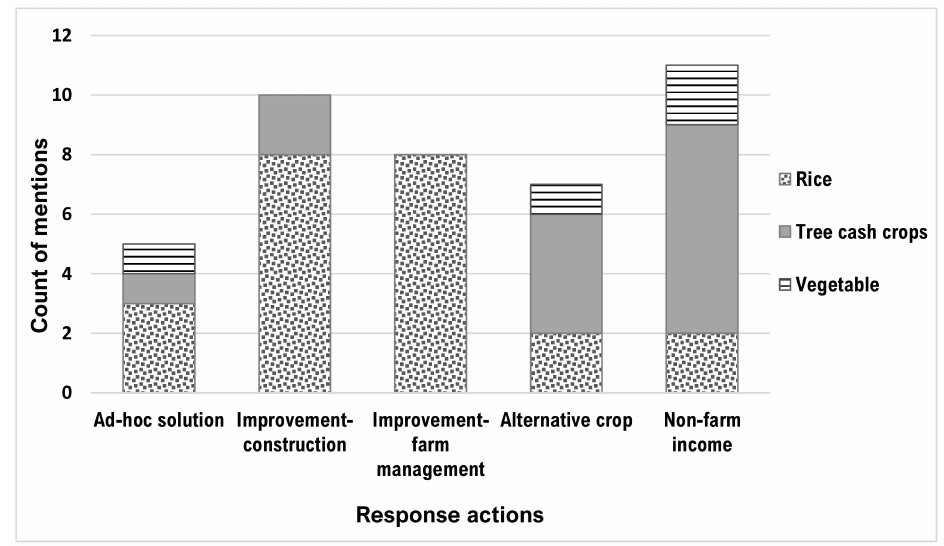
Figure 4. Response actions in four landscapes for the three impacts under the AP